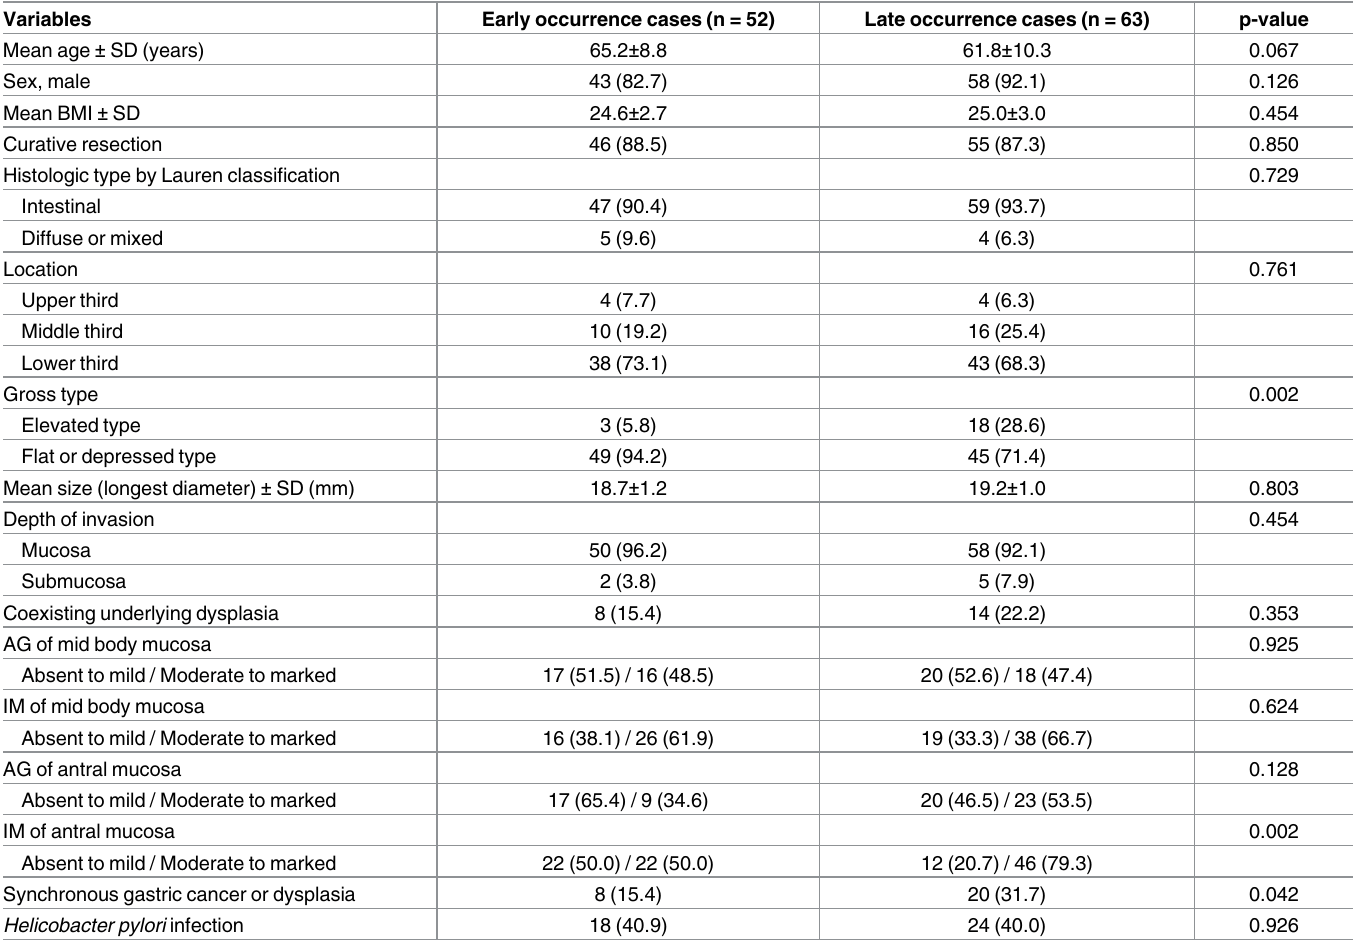
Table 1. Comparison of clinicopathological characteristics between the early occurrence casesand the late occurrence